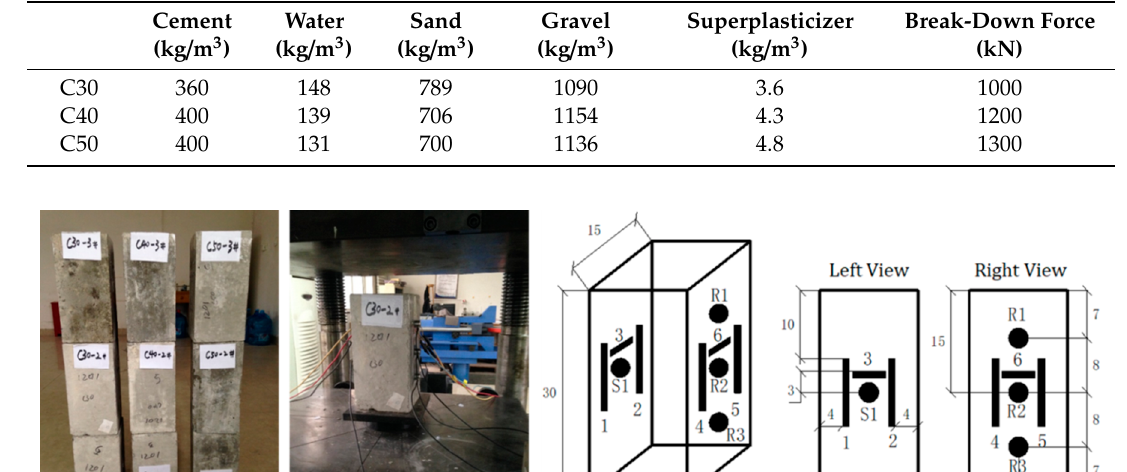
Table 1. The mix proportion and mechanical properties.